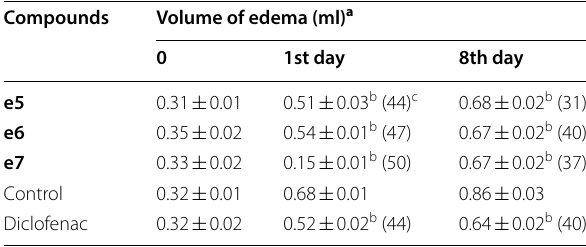
Table 39 Anti-inflammatory activity of the fused thienopyrimidines in formalin-induced rat paw edema bioassay (acute inflammatory model)